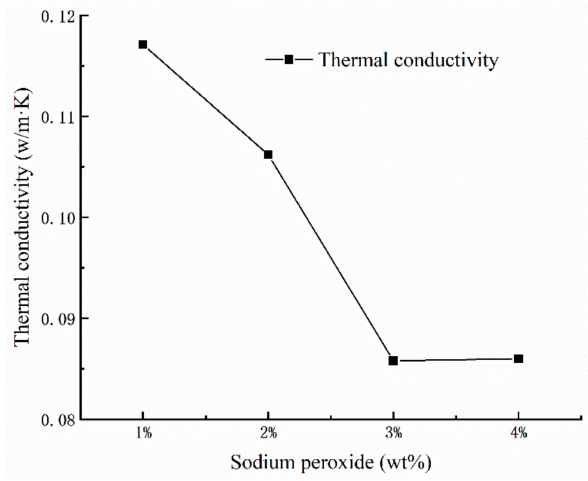
Figure 3. Dependence of thermal conductivity versus the mass fraction of Na 2 O 2